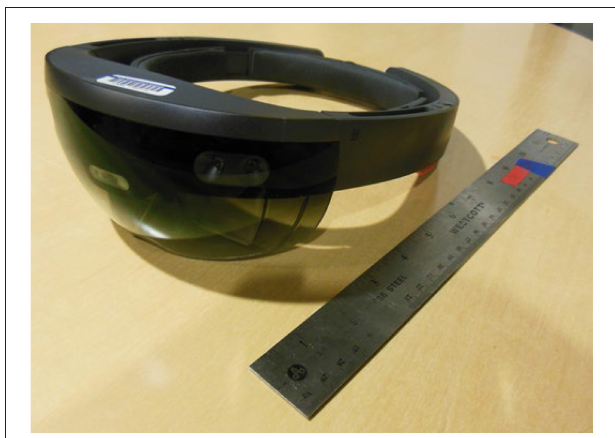
FIGURE 1 | An example of an augmented reality headset [Microsoft HoloLens, Microsoft,